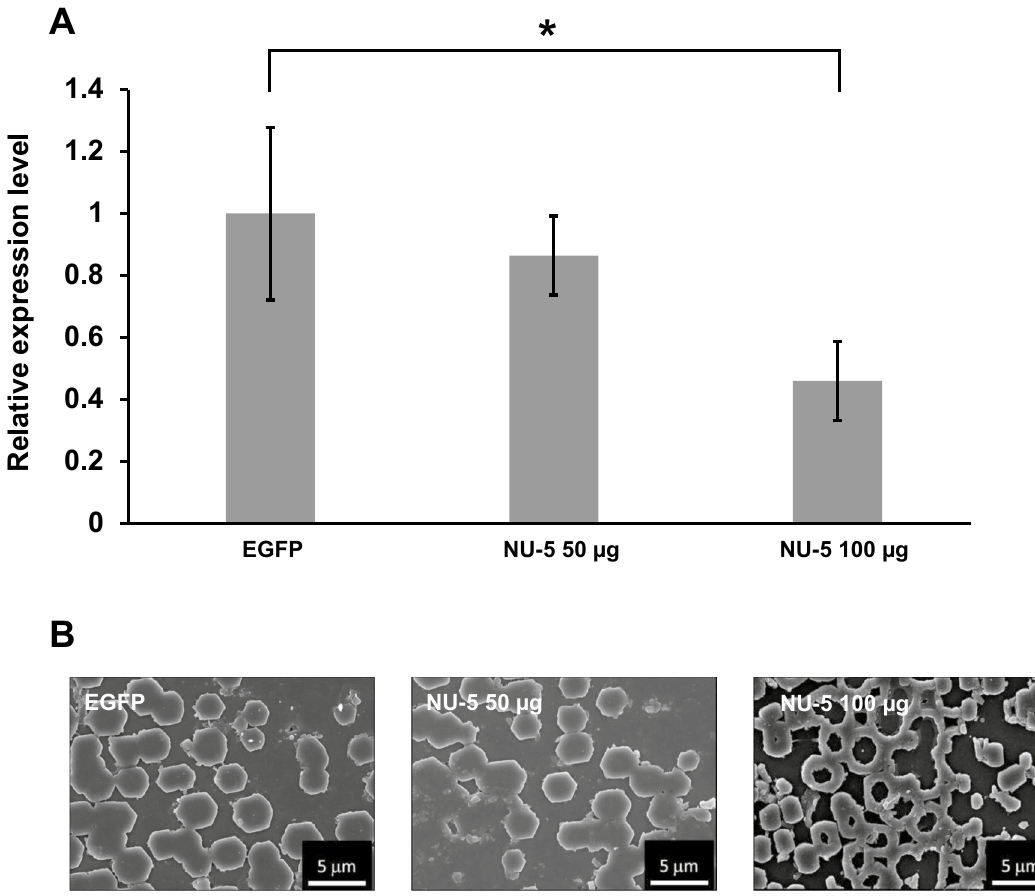
Figure 4. ( A ) Relative gene expression levels of NU-5 4 days after injection of dsRNAf of NU-5. dsRNA of EGFP was injected as negative control. qPCR was performed to evaluate relative gene expression levels compared with EGFP. Data are expressed as the mean ± S.E. Statistically significant differences were determined by t-test (* p < 0.05, n = 3). ( B ) Surface microstructure images of the nacreous layer 4 days after injection observed using SEM. The surface is the growth front of the nacre. In the condition of NU-5 100 µg, the normal nacre formation was disrupted.